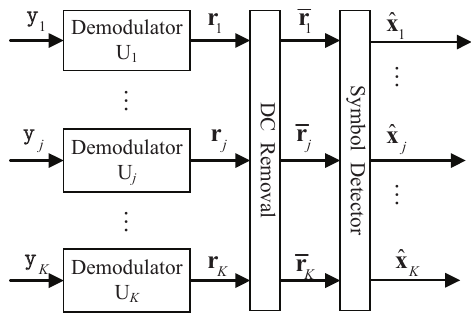
Figure 3. The receiving structure of the